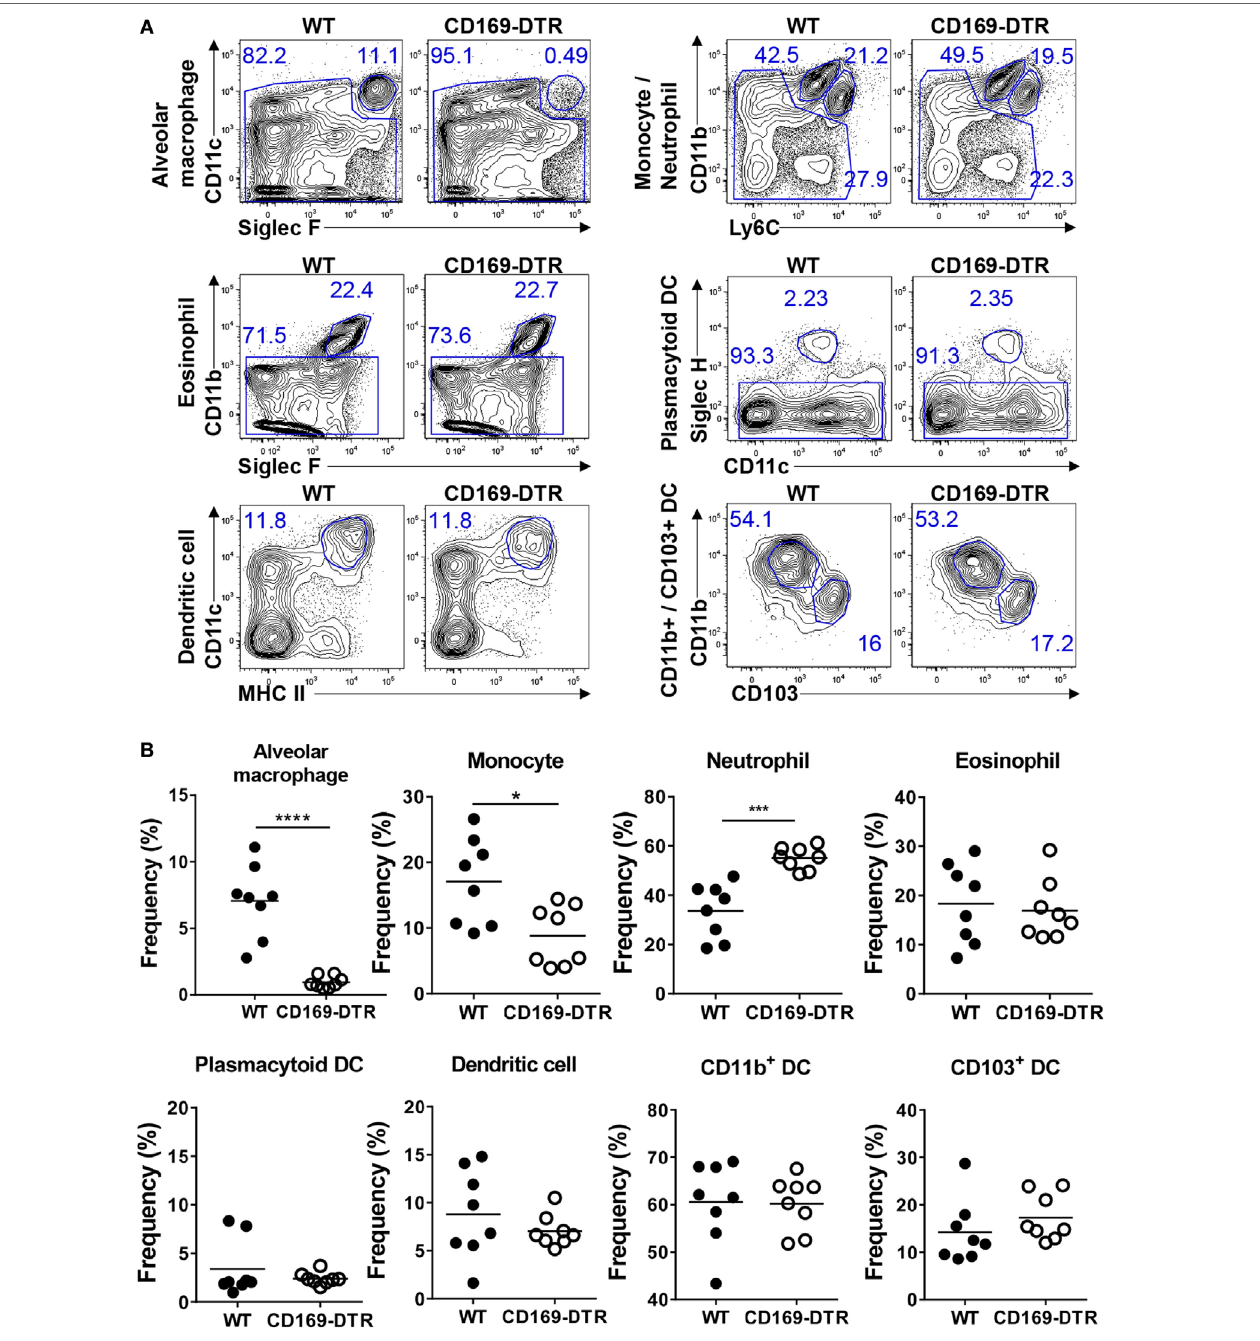
FigUre 1 | Diphtheria toxin (DT) administration to CD169-diphtheria toxin receptor (DTR) mice induces alveolar macrophage (AM) depletion and reduces monocyte recruitment. (a) Lung cells isolated from wild-type (WT) and CD169-DTR mice 1 day after DT treatment were stained with the indicated antibodies and analyzed by flow cytometry. AMs, monocytes, neutrophils, eosinophils, plasmacytoid dendritic cells, dendritic cells (DCs), CD11b + DCs, and CD103 + DCs were defined by their surface marker expression. The gating strategy is described in Figure S1 in Supplementary Material. (B) Results are shown as dot graphs. Each dot represents an individual mouse ( n = 8 in each group). Statistically significant differences are indicated: * P < 0.05, *** P < 0.001, **** P < 0.0001. Data are representative of three independent experiments.